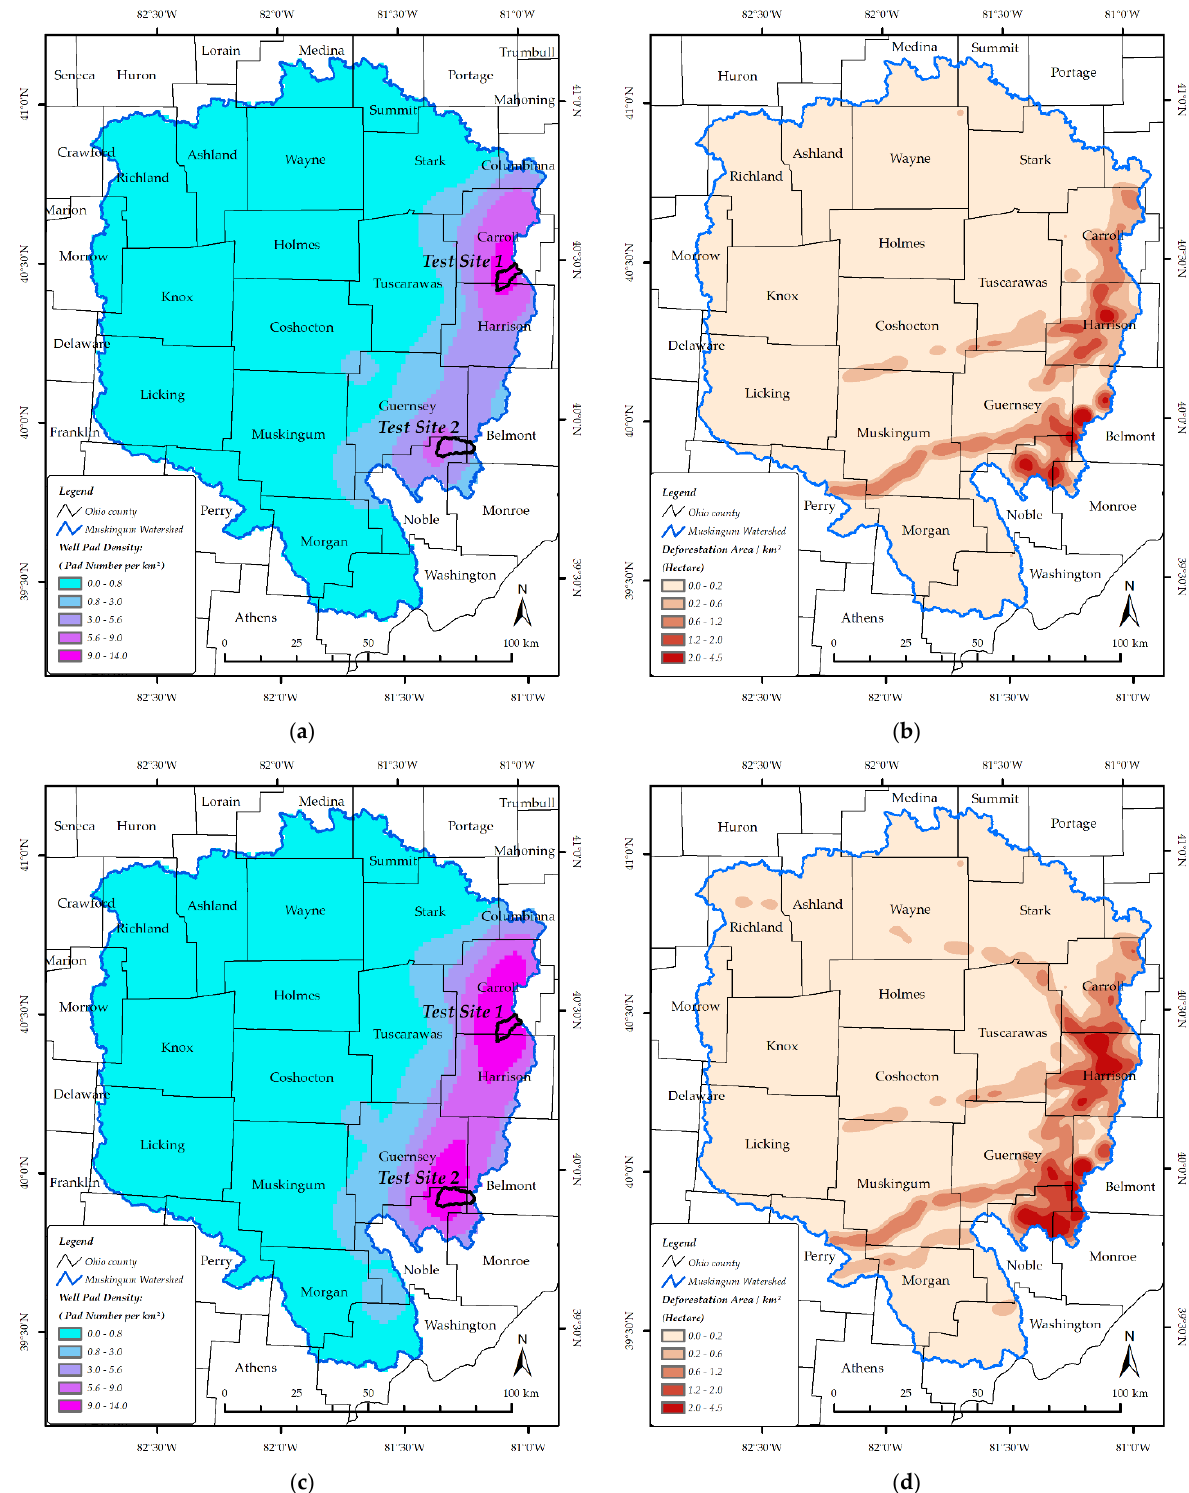
Figure 9. Spatial distribution of well pads and deforestation: ( a ) well pad density near the peak of the boom; ( b ) deforestation density near the peak of them boom; ( c ) well pad density at the end of the boom; ( d ) deforestation density at the end of them boom. Test Site 1 was the Dining Fork Catchment, and Test Site 2 was the Beaver Creek Catchment. The spatial pattern of deforestation was consistent with the spatial pattern of these unconventional shale gas extraction activities (Figure 10). Correspondingly, the dense shale gas extraction activities in the Muskingum River Watershed totally caused 2201.61